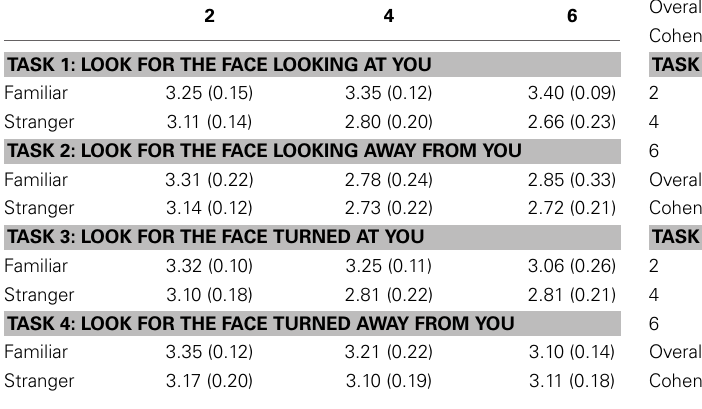
Table 2 | Mean d (cid:2) values and SE ( N = 8, in parenthesis) for each task and condition. 2 4 6